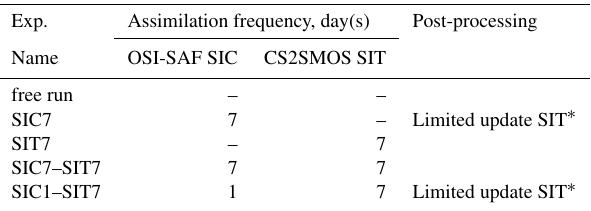
Table 1. Summary of the ensemble experiments. For all the exper- iments, the simulation period is from 18 October 2019 to 16 April 2020, and the ensemble size is 40.